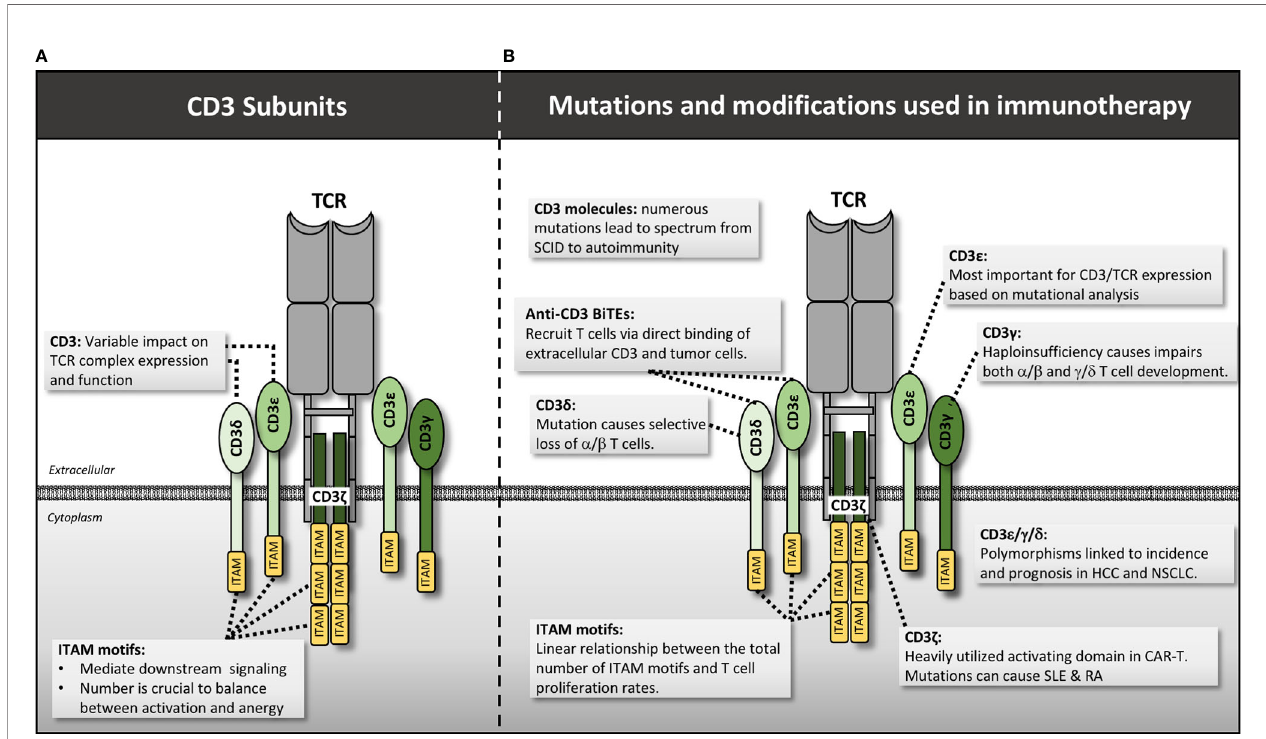
FIGURE 3 | CD3 structure, mutations and manipulations for immunotherapy. (A) CD3 molecules interact with the TCR in CD3 d / ϵ and CD3 ϵ / g heterodimers while CD3 z forms a single homodimer. Each CD3 molecule contains one or more ITAM motif that is essential for downstream signaling. (B) Various mutations and genetic engineering approaches alter or manipulate CD3 function thereby impacting T cell activity. HCC, hepatocellular carcinoma; NSCLC, non-small cell lung